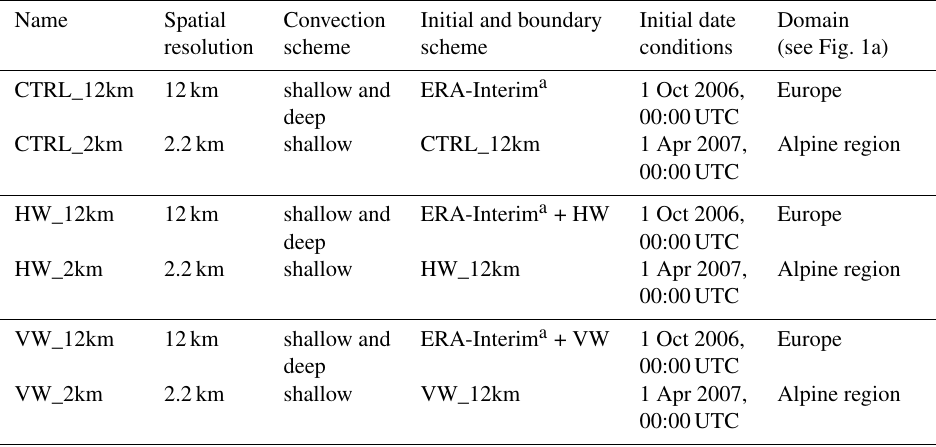
Table 1. Overview and specifications of the simulations analyzed in this paper. Name Spatial Convection Initial and boundary Initial date Domain resolution scheme scheme conditions (see Fig. 1a) CTRL_12km 12km shallow and ERA-Interim a 1 Oct 2006, Europe deep 00:00UTC CTRL_2km 2.2km shallow CTRL_12km 1 Apr 2007, Alpine region 00:00UTC HW_12km 12km shallow and ERA-Interim a + HW 1 Oct 2006, Europe deep 00:00UTC HW_2km 2.2km shallow HW_12km 1 Apr 2007, Alpine region 00:00UTC VW_12km 12km shallow and ERA-Interim a + VW 1 Oct 2006, Europe deep 00:00UTC VW_2km 2.2km shallow VW_12km 1 Apr 2007, Alpine region